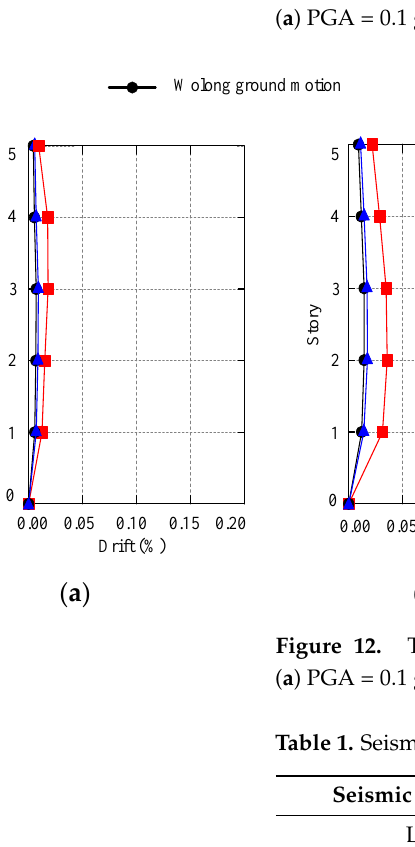
Figure 11. The maximum relative displacement response of stories under ground motions input. ( a ) PGA = 0.1 g, ( b ) PGA = 0.22 g, ( c ) PGA = 0.4 g, ( d ) PGA = 0.62 g.